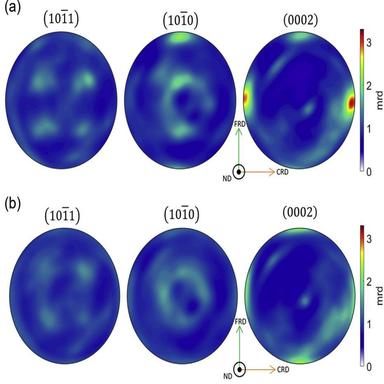
ODF pole figure for the as-received material at a depth of (a) 0.5 mm and (b) 2 mm.